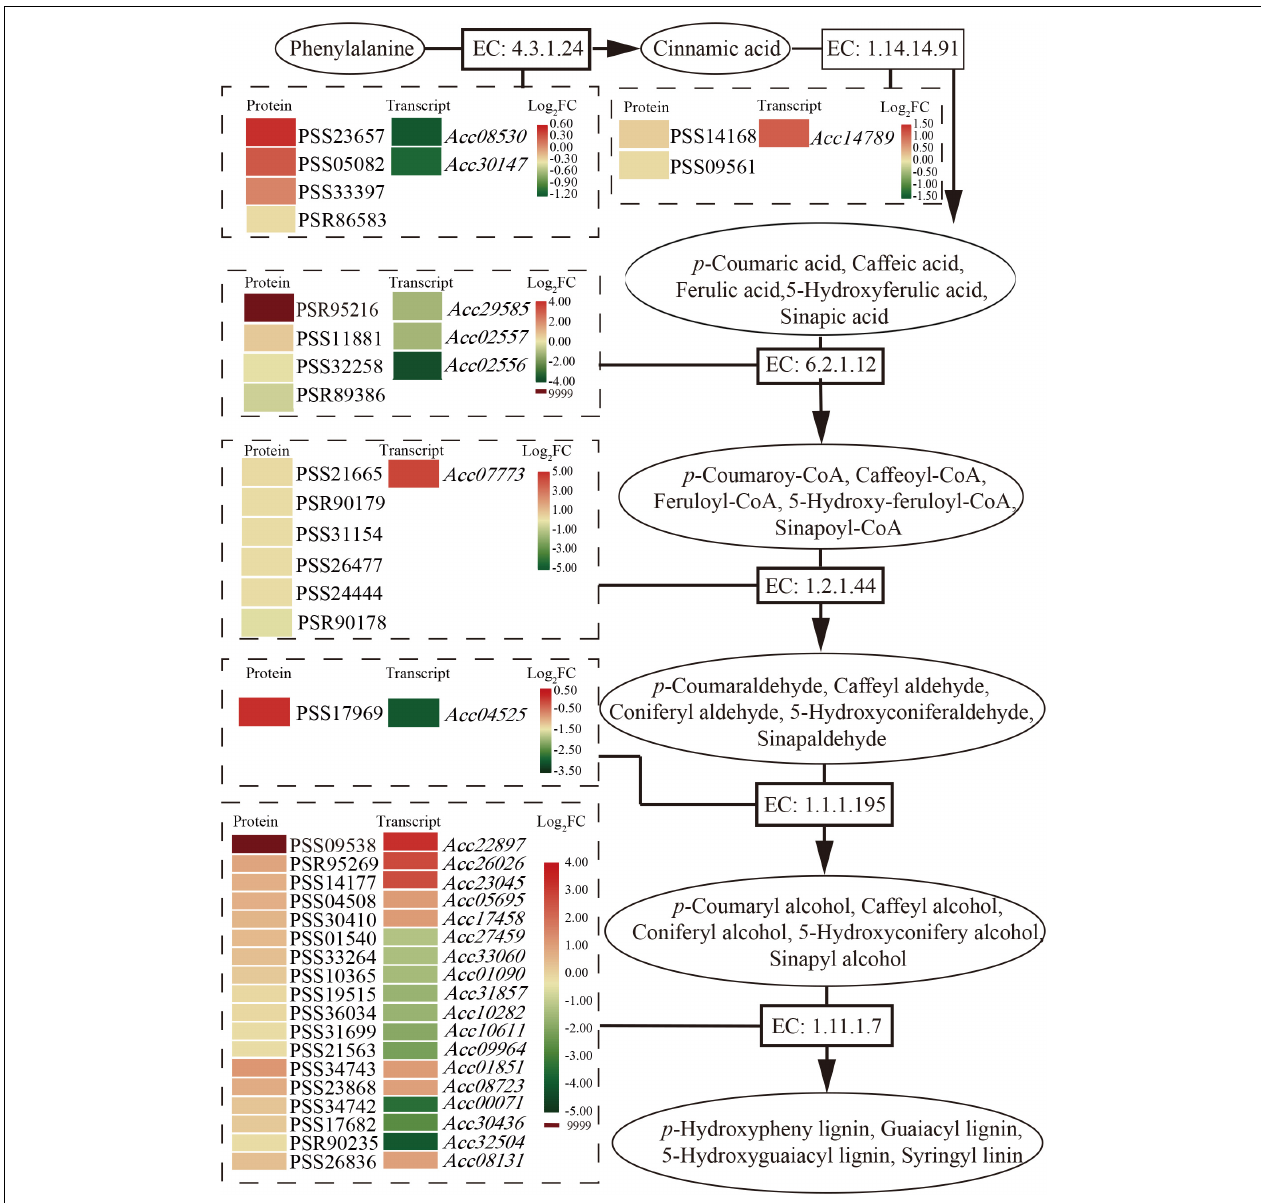
FIGURE 4 | Schematic of the transcriptome and proteome revealing the regulation of phenylpropanoid biosynthesis at 1 dpi of Psa in ‘Jinkui’ leaves.